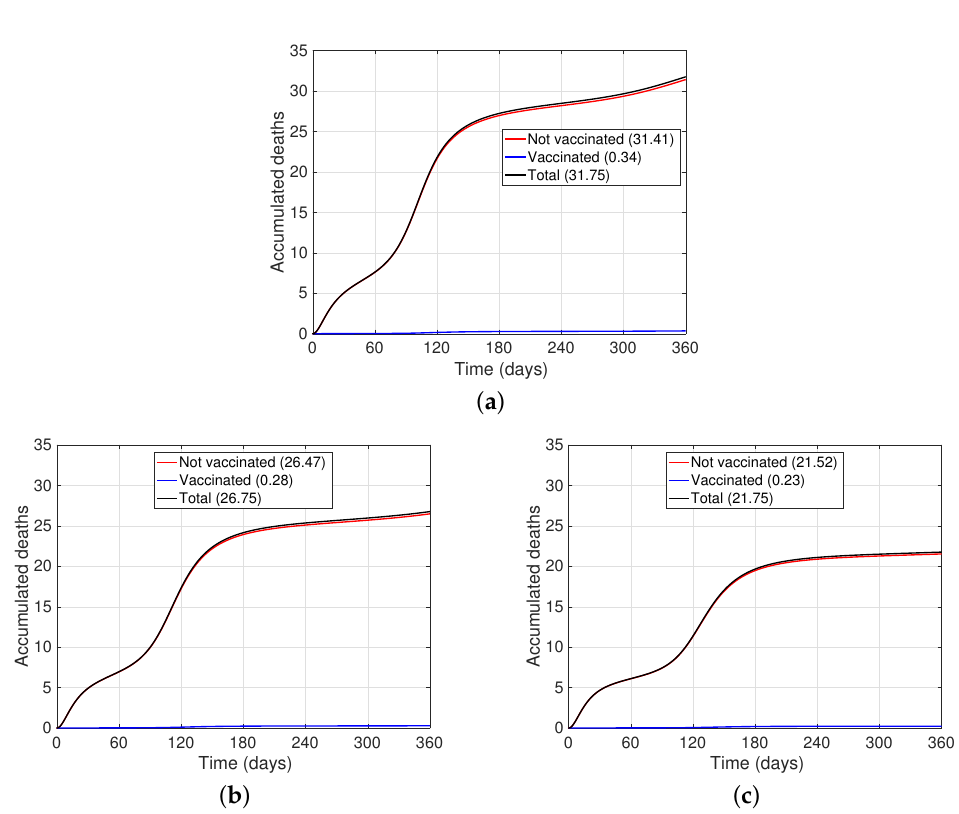
Figure 6. Accumulated deaths associated with SARS-CoV-2. ( a ) Base case. ( b ) Half the rate of resistance to change ( Λ 1 ), that is, people are less reticent to change their behavior with PPE and reduce social distancing. A similar graph is obtained after doubling the speed of people’s reaction to the pandemic ( Λ 2 ). ( c ) Reduction of resistance to change by half and increase in reaction speed by